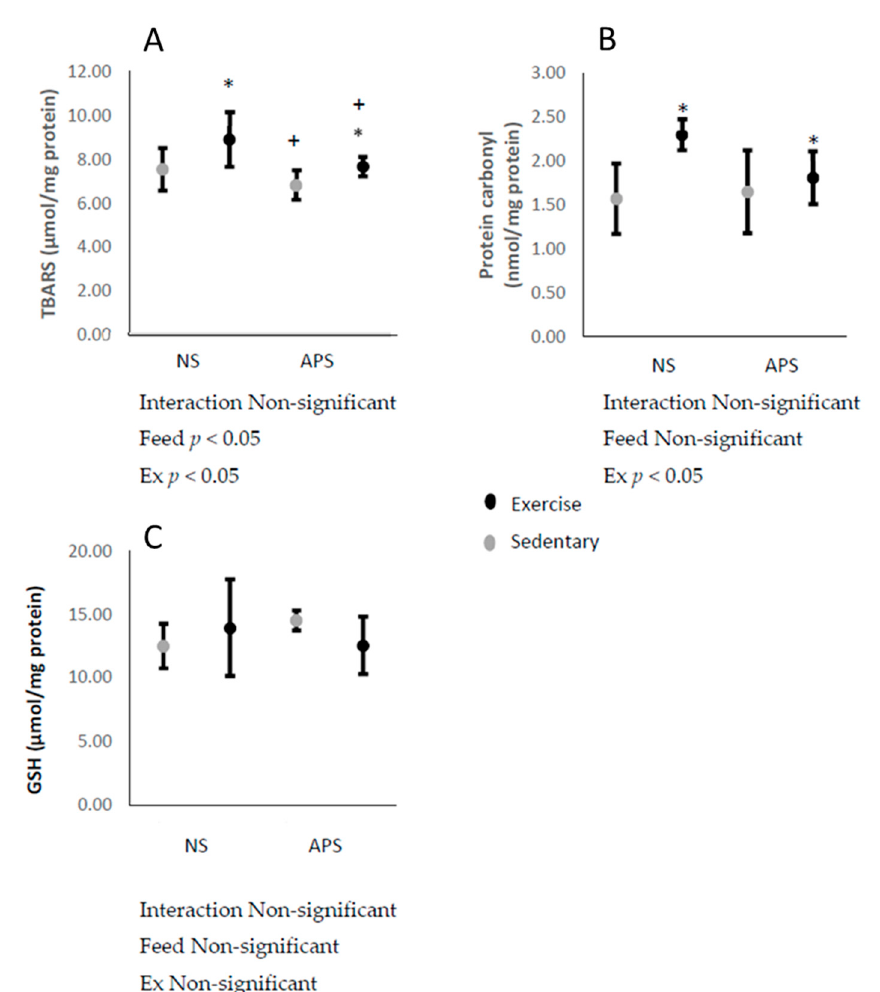
Figure 4. Means ± SEM: ( A ) skeletal muscle TBARS (control, n = 6; APS, n = 6; Ex, n = 6; Ex + APS, n = 5), ( B ) protein carbonyl (control, n = 6; APS, n = 5; Ex, n = 5; Ex + APS, n = 6), ( C ) and GSH (control, n = 6; APS, n = 6; Ex, n = 6; Ex + APS, n = 6). NS: non-supplemented groups, APS: acacia